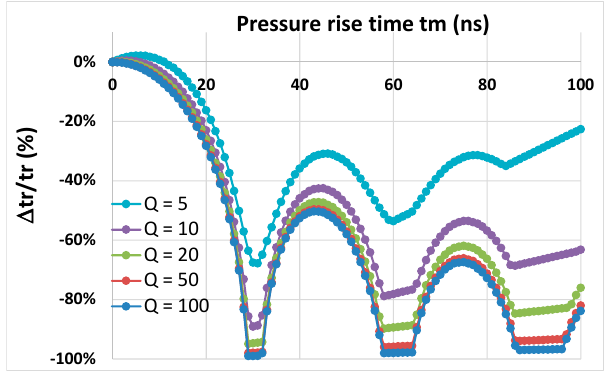
Figure 7. Relative sensor reaction time versus pressure rise time for different Q